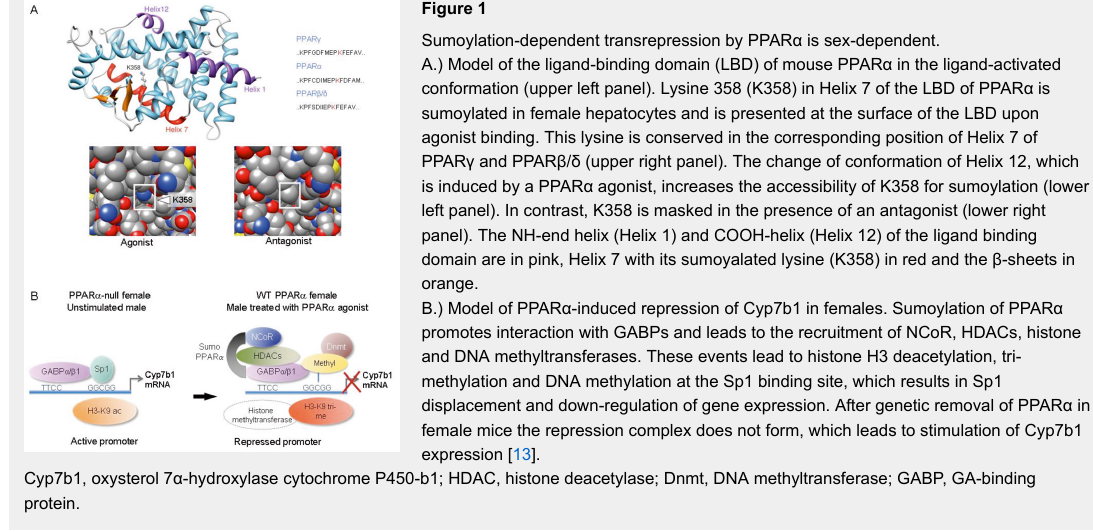
Figure 2 Metabolic functions of PPARs. Compilation of the known main metabolic functions of PPARα, PPARβ/δ and PPARγ in the liver, muscle, adipose tissue and